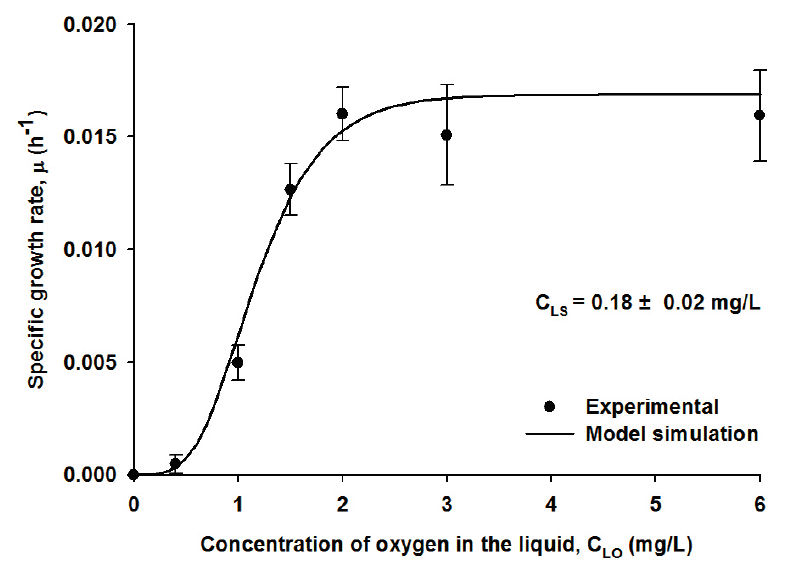
Figure 2. The specific growth rates of the SOB strain as a function of the oxygen concentrations in the liquid medium. The symbols show averaged experimental data with standard deviations, and the line illustrates model